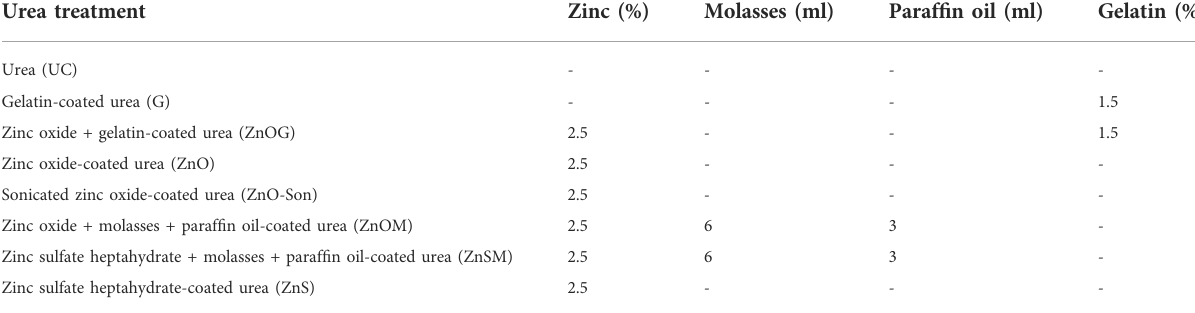
TABLE 1 Compositions of urea fertilizer treatments. Urea